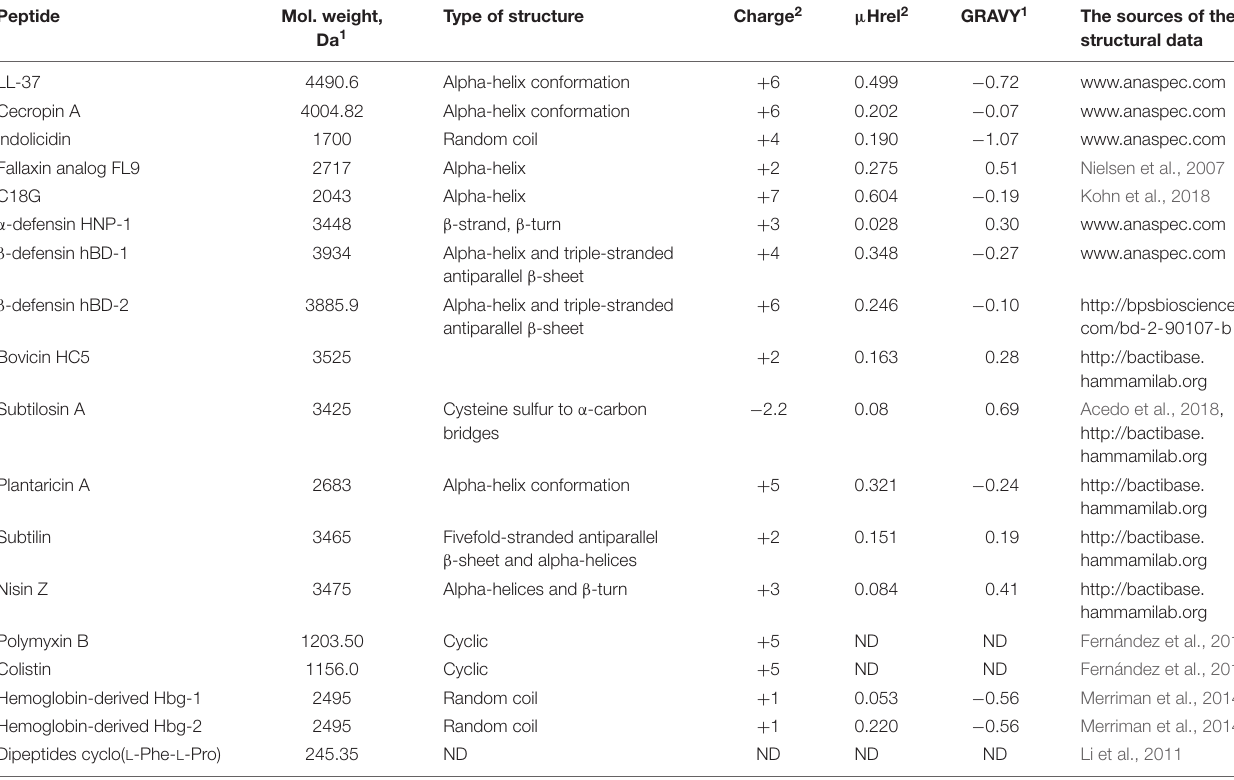
TABLE 1 | The physico-chemical properties of antimicrobial peptides described in the review.